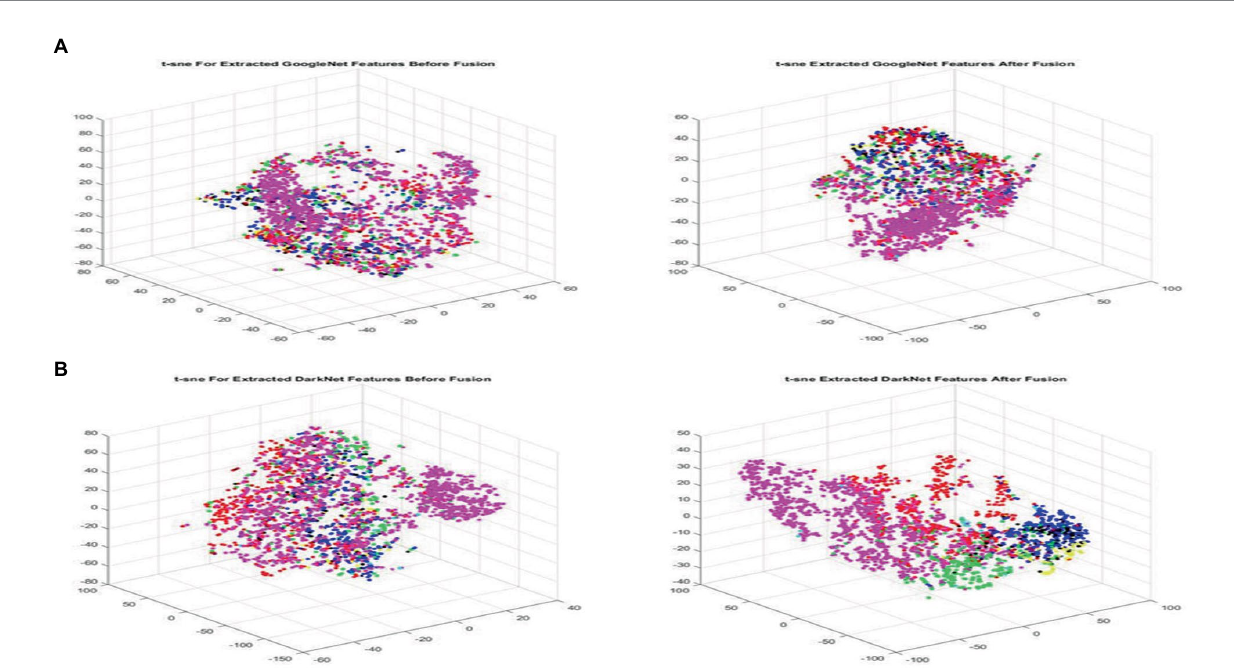
FIGURE 4 Visualizing extracted features before (left) and after (right) fusion using t-SNE for GoogleNet and DarkNet, respectively, best viewed in color. (A) GoogleNet and (B)